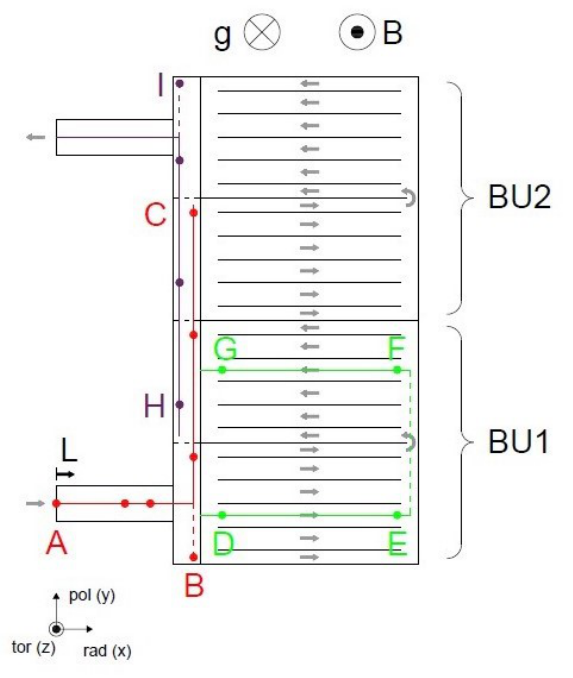
Figure 13. 2D view (radial-poloidal) of the TBM geometry. The flow path underlined with colored segments (A-I) is used in the following for pressure drop calculation.